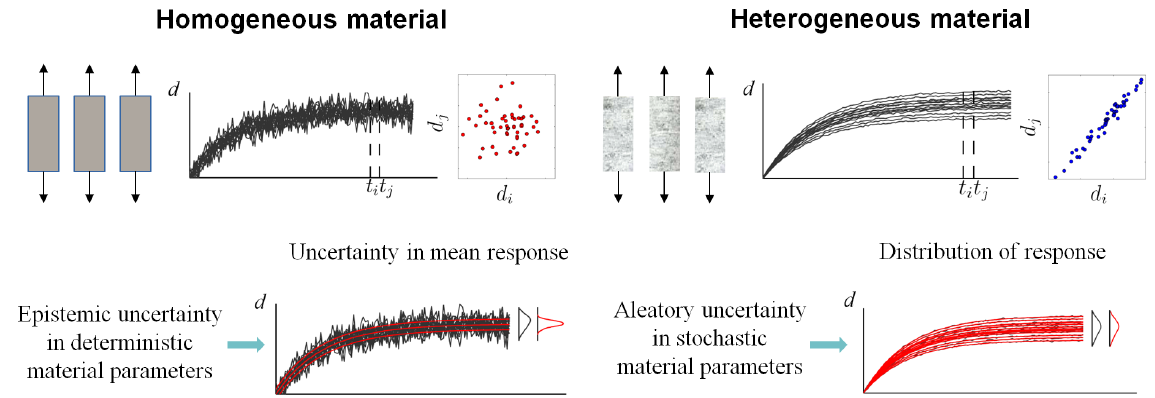
Figure 1. Uncertainties in properties of a homogeneous and heterogeneous